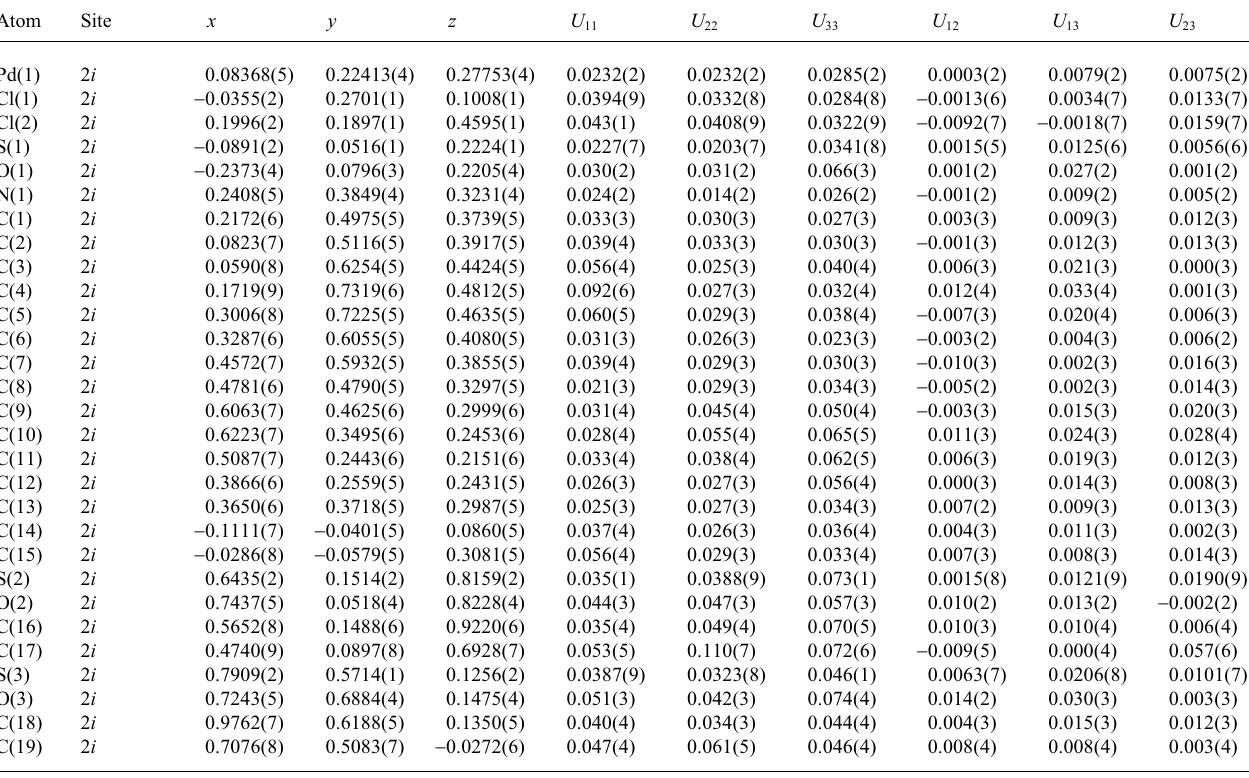
Table 3. Atomic coordinates and displacement parameters (in Å 2